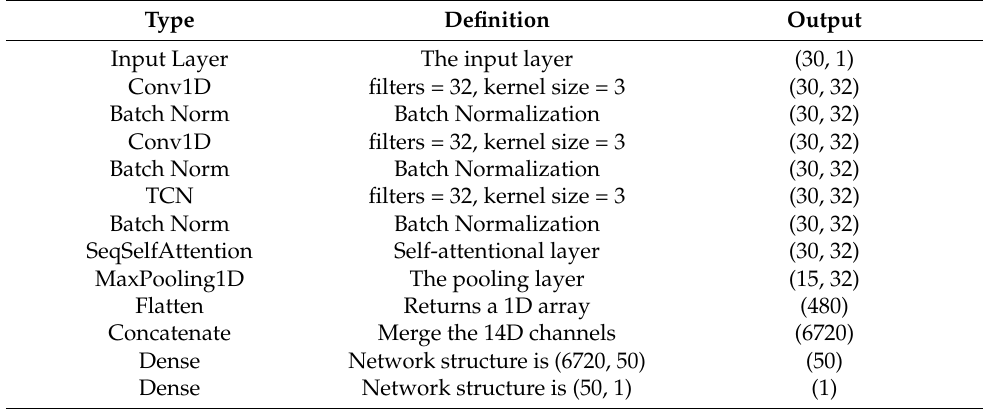
Table 6. Network parameters based on CNN-TCN and multi-head